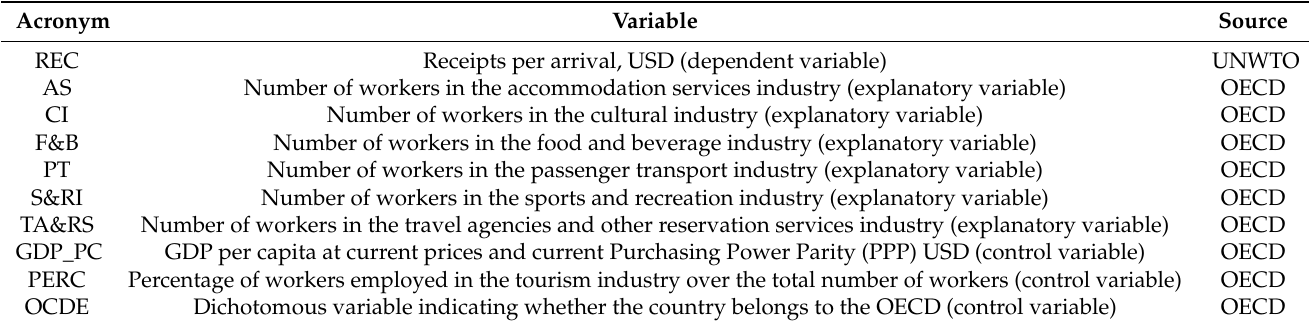
Table 1. List of